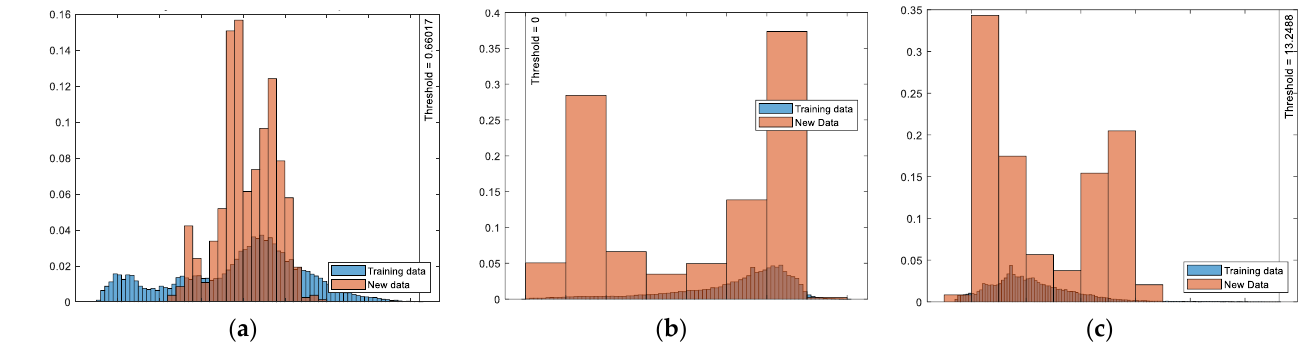
Figure 5. Detecting anomalies in unsafe pHRI test data in 2D-XZ plane (rep5): Histograms of novelty scores of ( a ) iForest, ( b ) OCSVM, and ( c ) Mahalanobis distance algorithms.